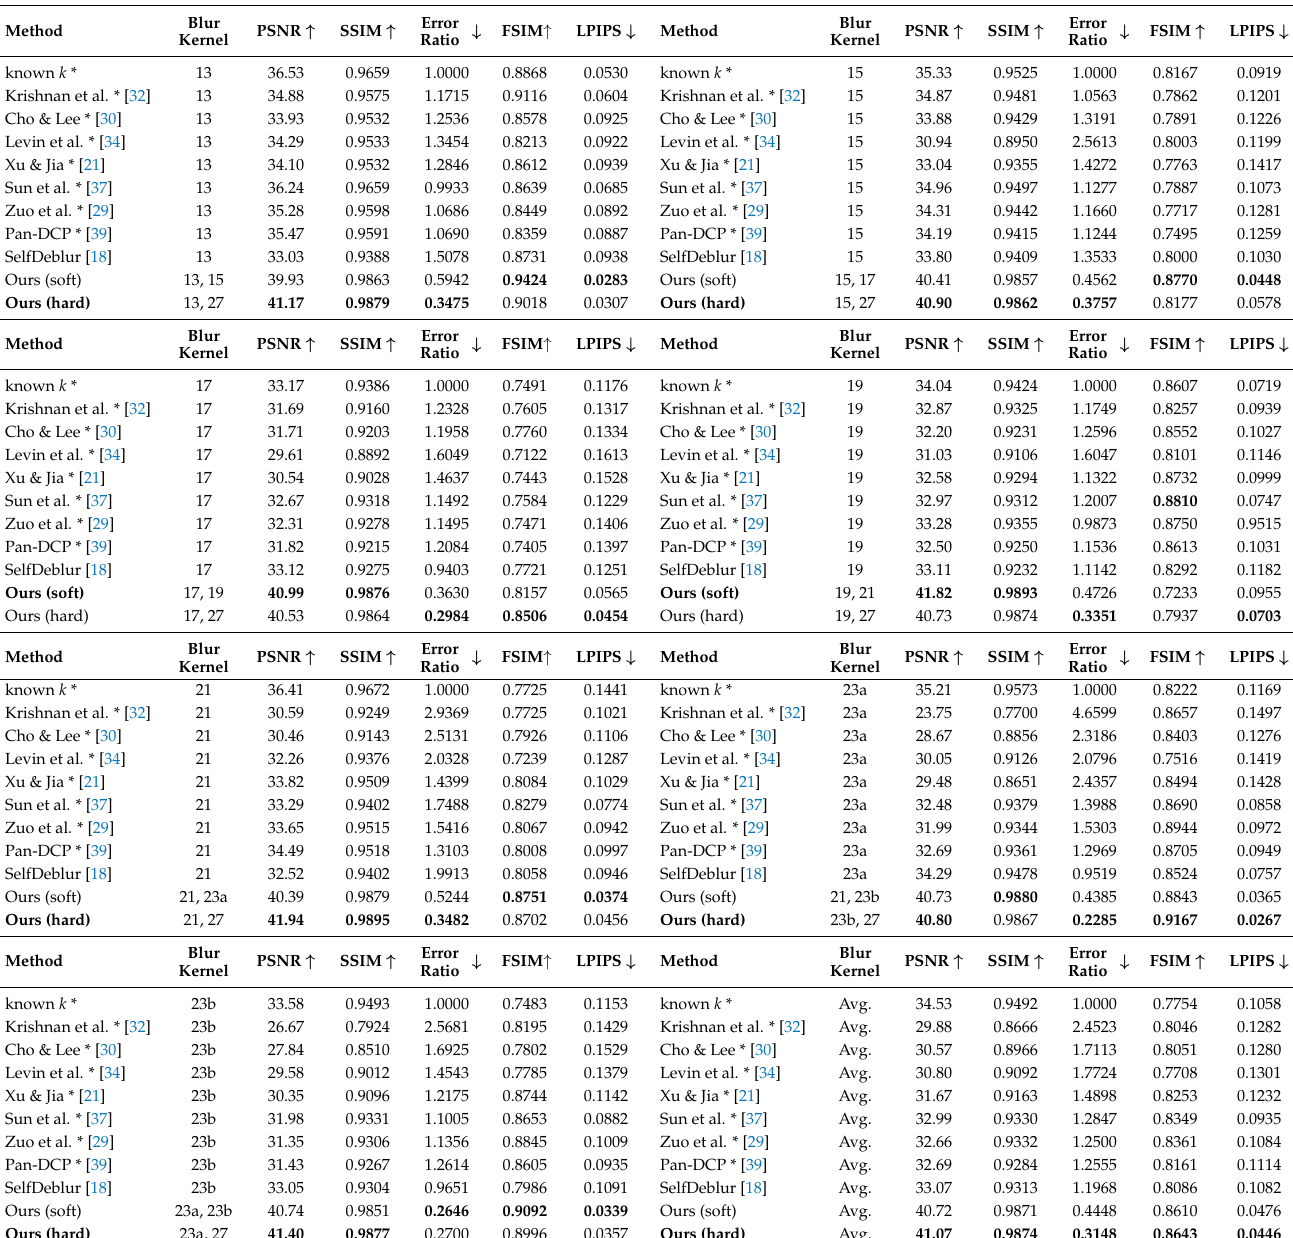
Table 4. Quantitative comparisons on the Levin test set [33]. * indicates that the method uses the non-blind deconvolution method of [34] to produce the final result. The best results are highlighted. Results of the blur kernel “Avg.” means the averagePSNR, SSIM, error ratio, FSIM and LPIPS results for all blur kernels.